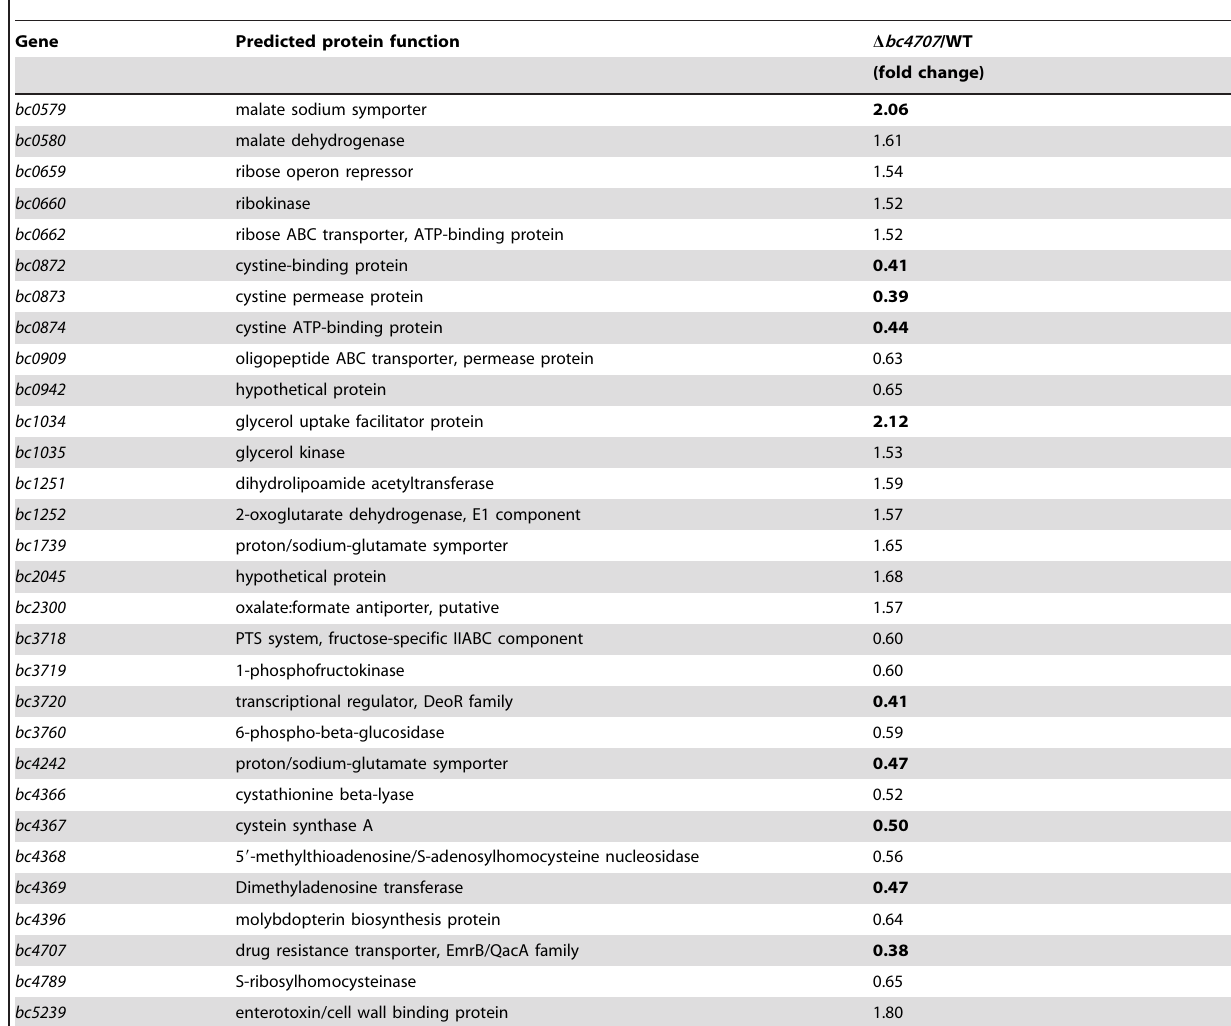
Table 3. Transcriptional profile of B. cereus ATCC14579 D bc4707 (AH1598) compared to wild type (AH1709) under logarithmic growth (OD 600 , 0.5) in rich